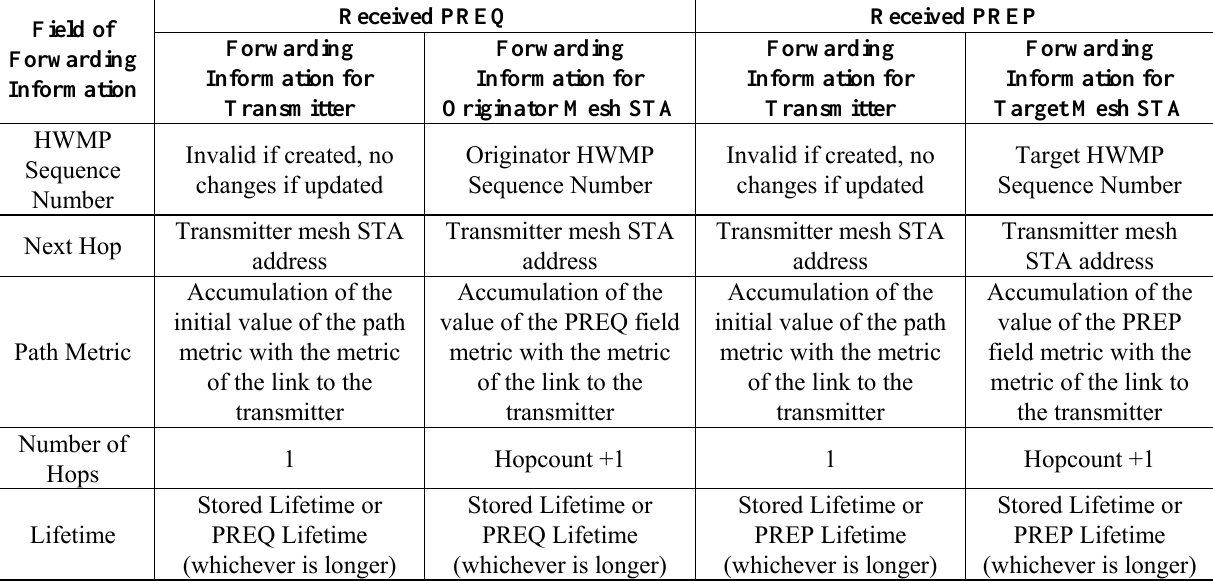
Table 3. Data for creating and updating forwarding information upon receiving PREQ and PREP